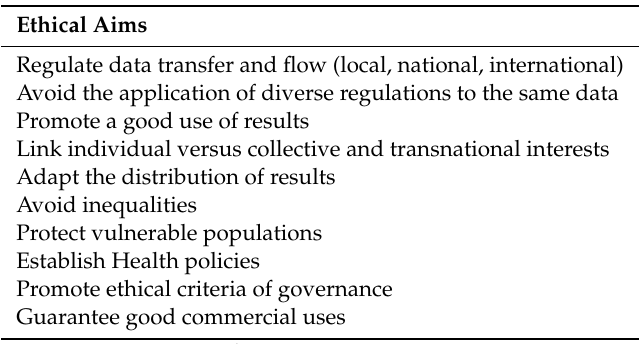
Table 4. Purposes of an International Regulation 1